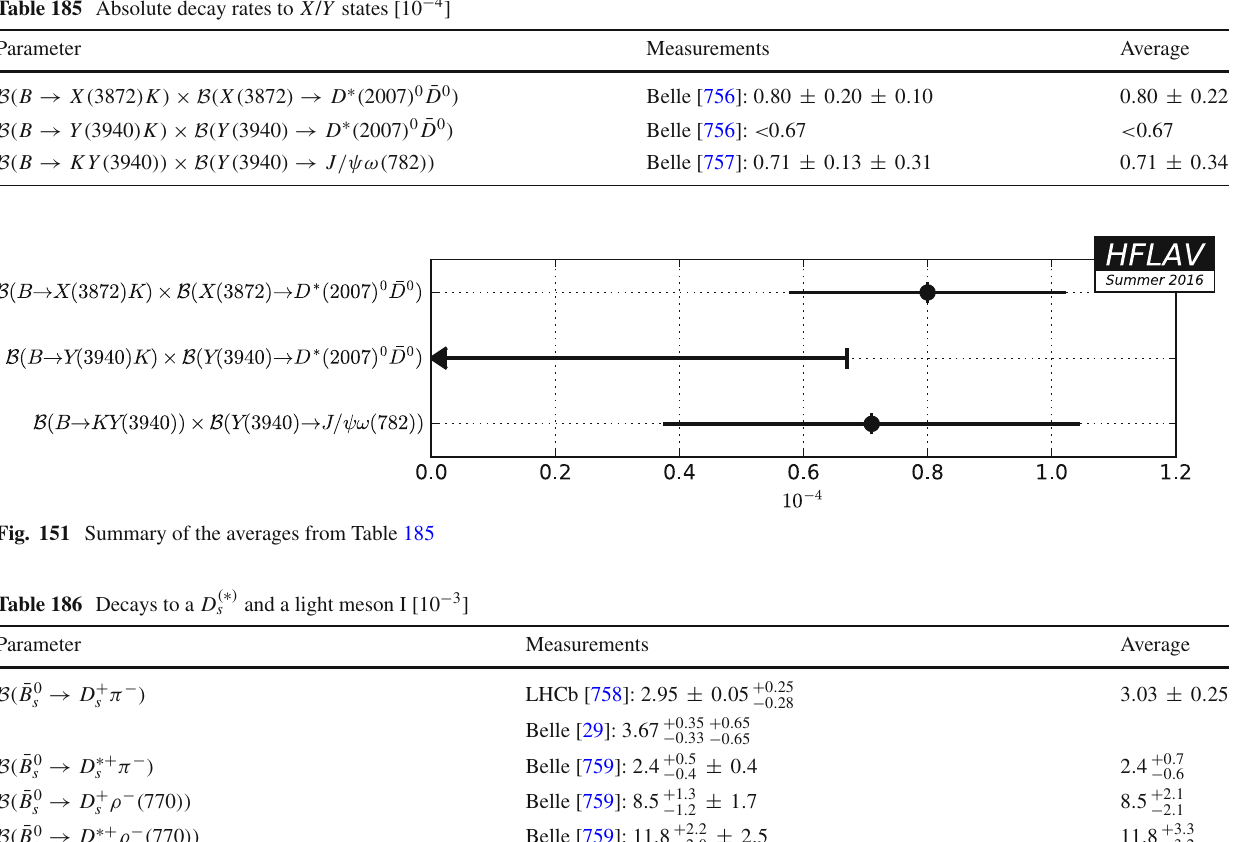
( ∗ ) s and a light meson II